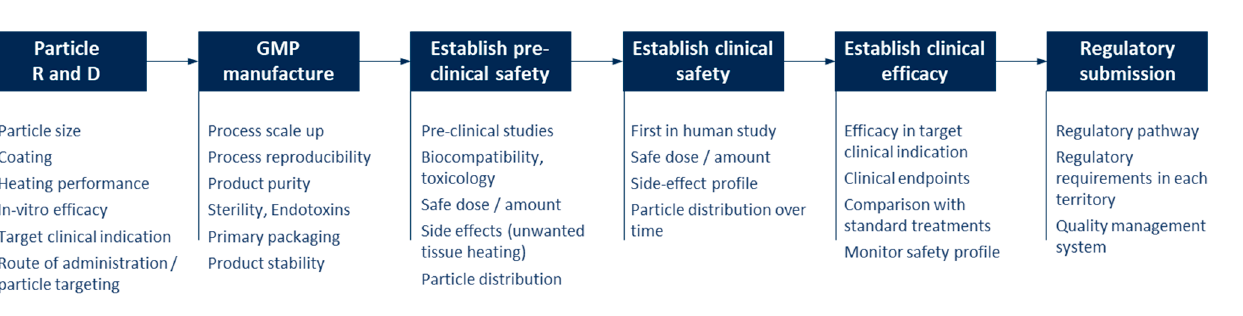
Figure 4. Steps to regulatory approval of MNPs for magnetic